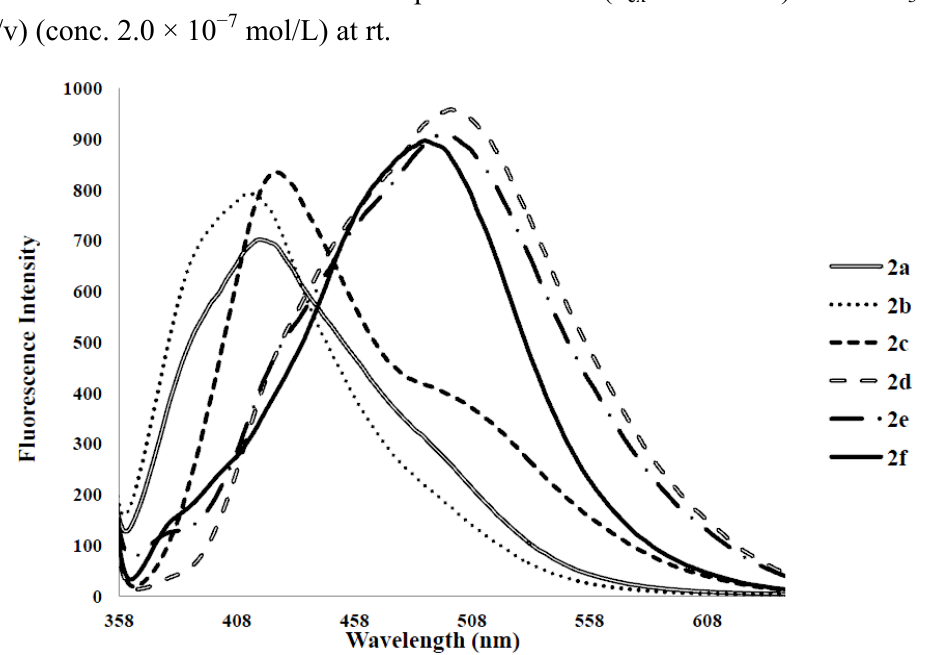
= 355 nm) in CHCl –MeOH ex 3